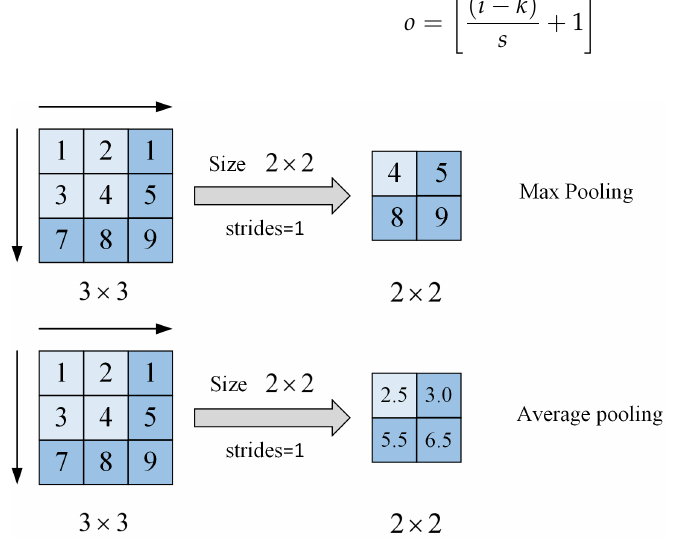
Figure 5. Max Pooling and Average pooling, it does not involve zero